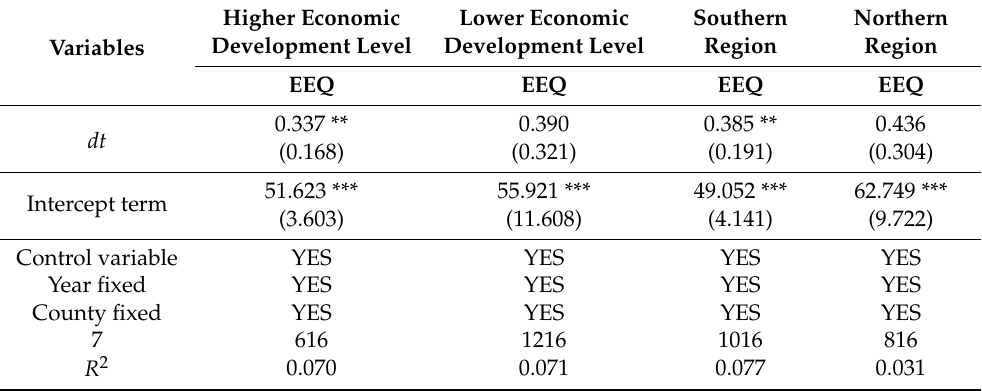
Table 9. Heterogeneity analysis of regional